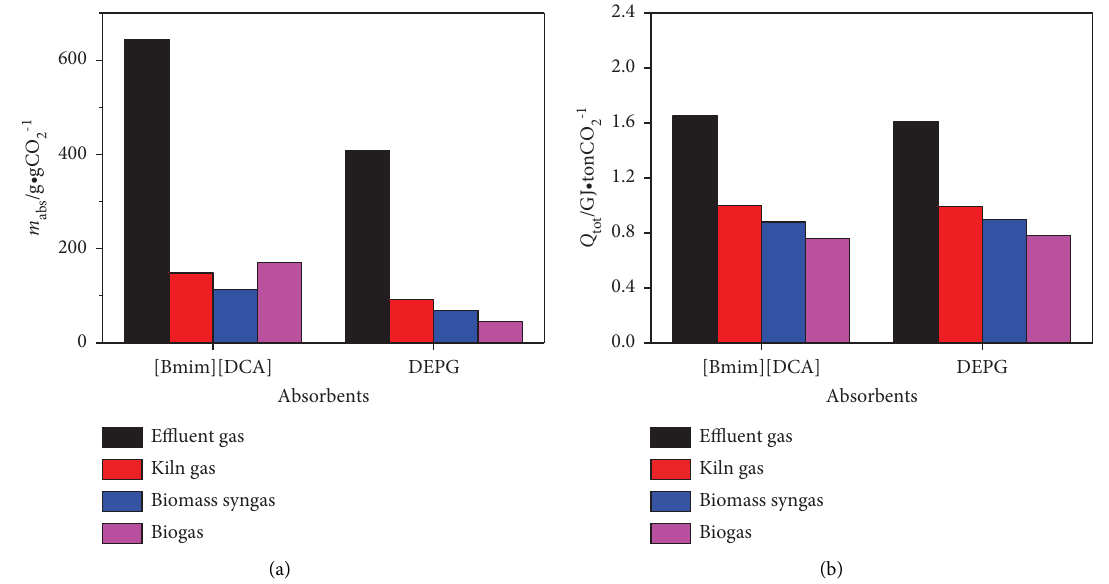
Figure 9: Te comparison of the performances of physical absorbents with P